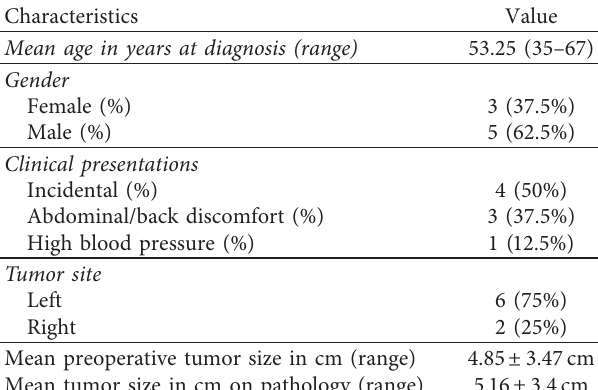
Table 1: Patients’ demographic and clinical